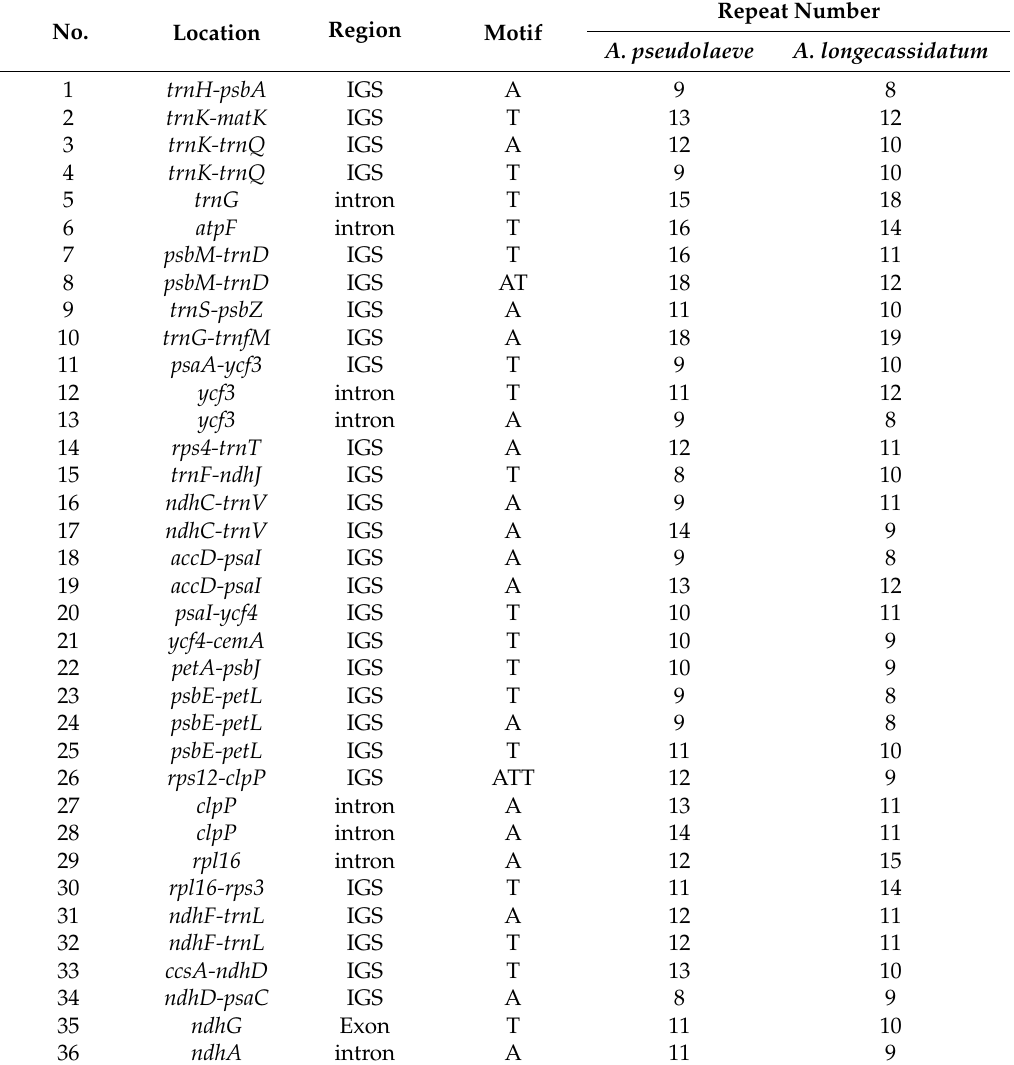
Table 4. Polymorphic SSRs between the A. pseudolaeve Nakai and A. longecassidatum Nakai CP genomes. CP: chloroplast; IGS: intergenic